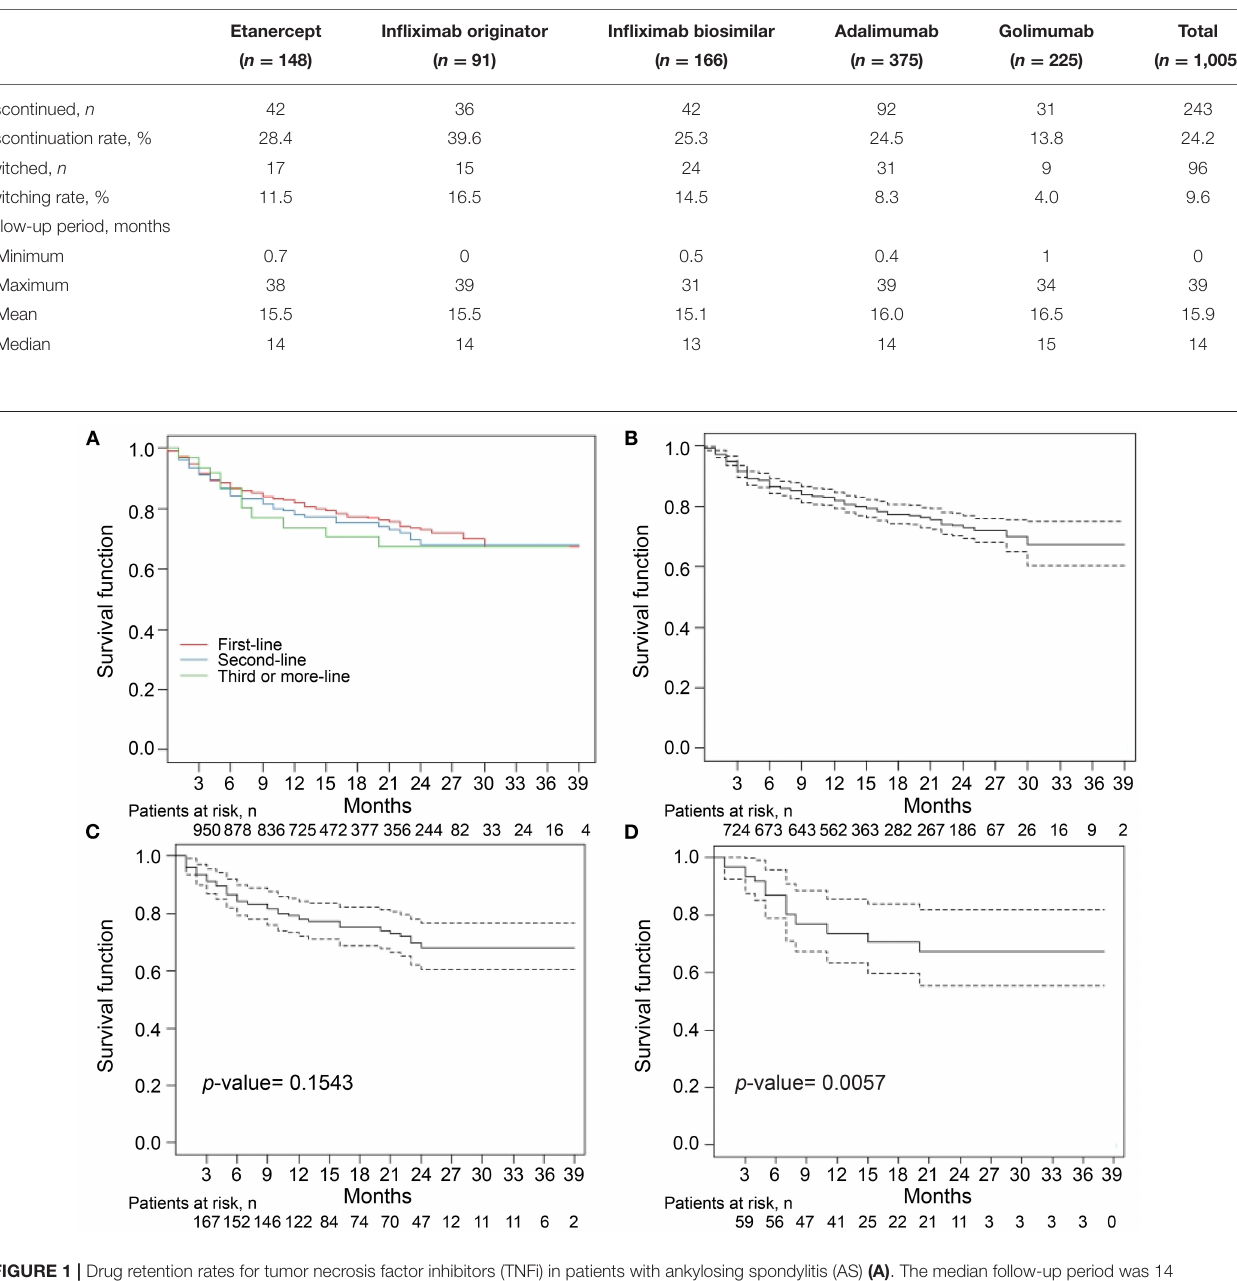
TABLE 2 | Retention rate of individual tumor necrosis factor inhibitors.